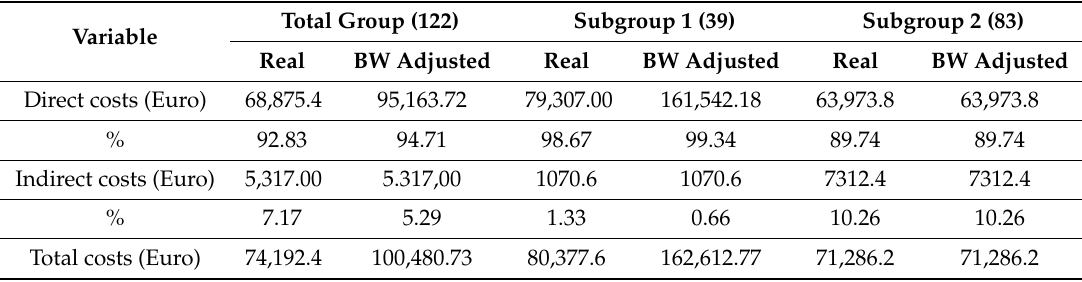
Table 7. Comparative distribution of the real and the BW-adjusted direct and indirect costs / patient / year and their proportion from the total costs (EUR).